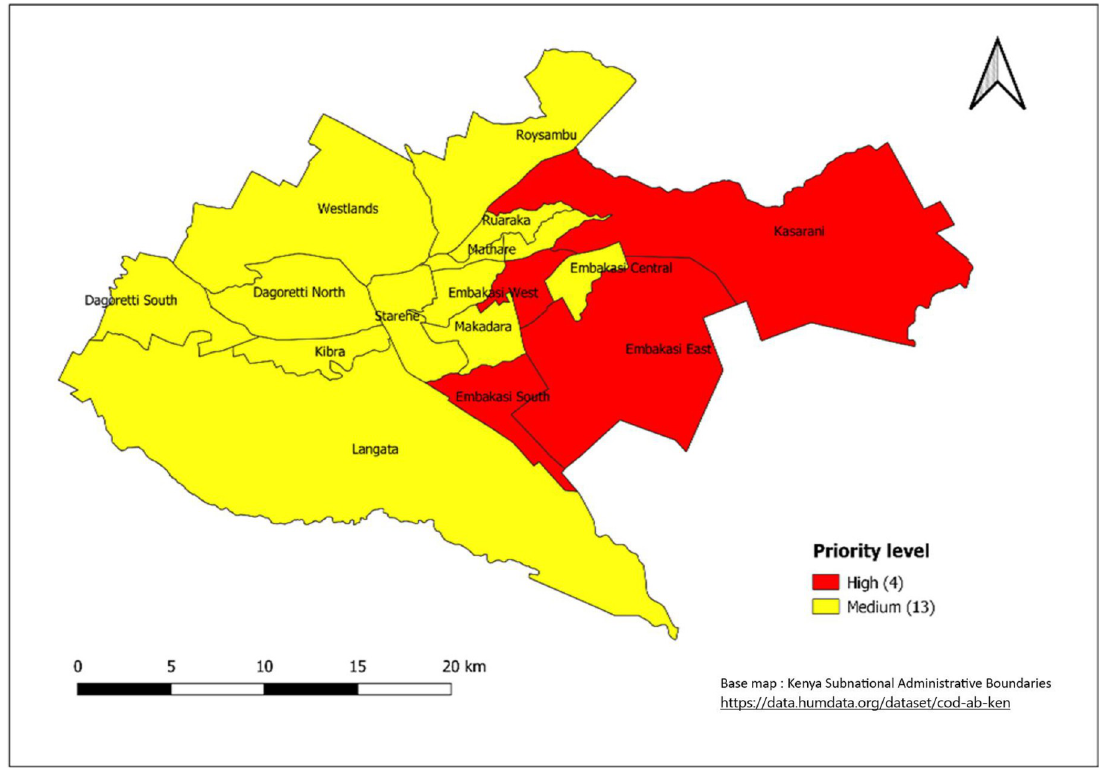
Fig 7. . Priority sub-counties in Nairobi County based on a combination of Epidemiological and WASH indicators, 2015–2019. Link to base map layer: https://data.humdata.org/dataset/cod-ab-ken Link to terms of use: https://data.humdata.org/faqs/licenses.